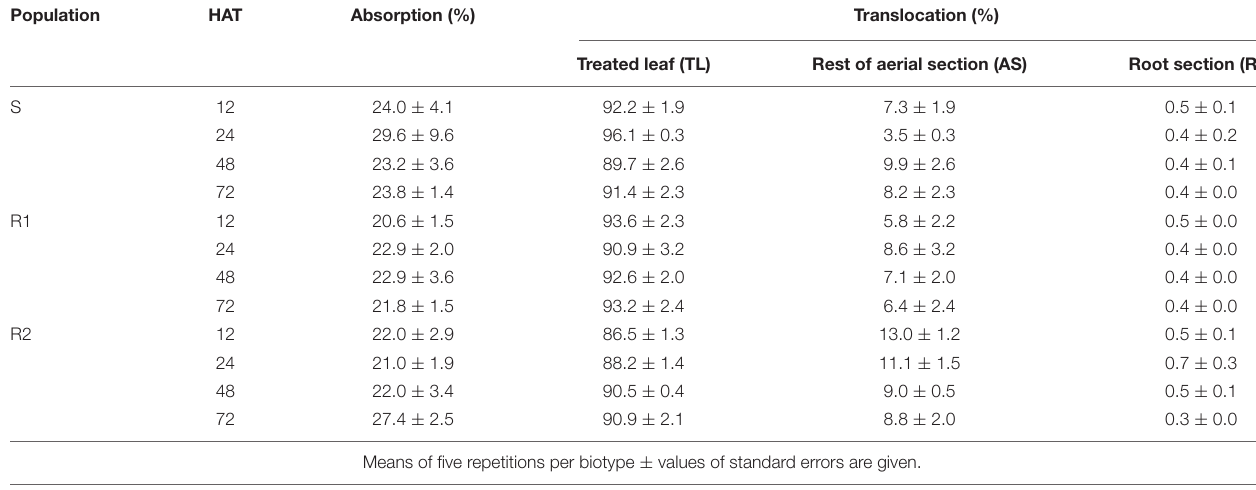
Rest of aerial section